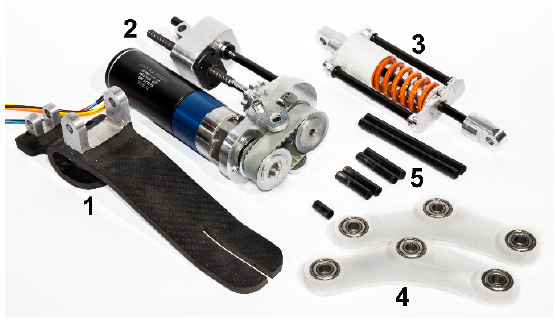
Figure 9. Components of the ankle-foot prosthesis prototype: 1. foot; 2. linear actuator and transmissions; 3. shock-absorber; 4. rocker arm; 5. structural pins.